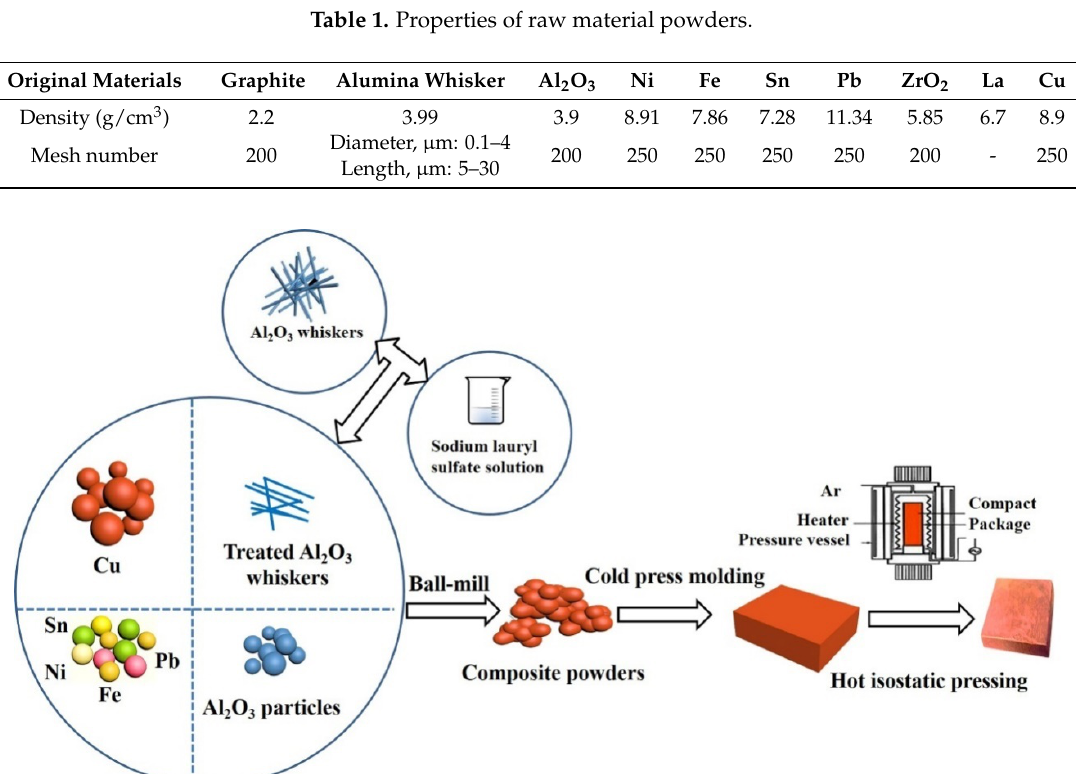
Table 1. Properties of raw material powders.